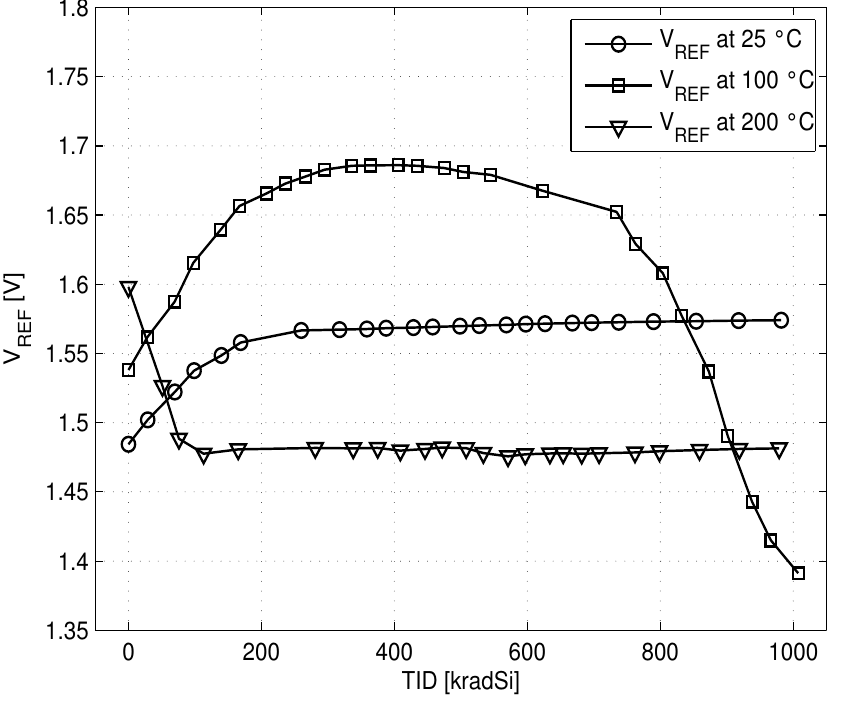
vs TID at different temperatures. REF